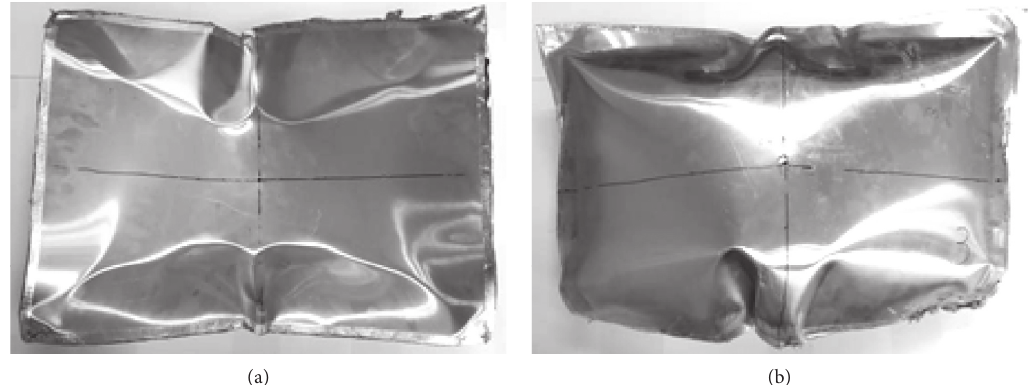
Figure 17: Front view of ST3 deformation. (a) Explosion-facing panel. (b) Explosion-back panel.